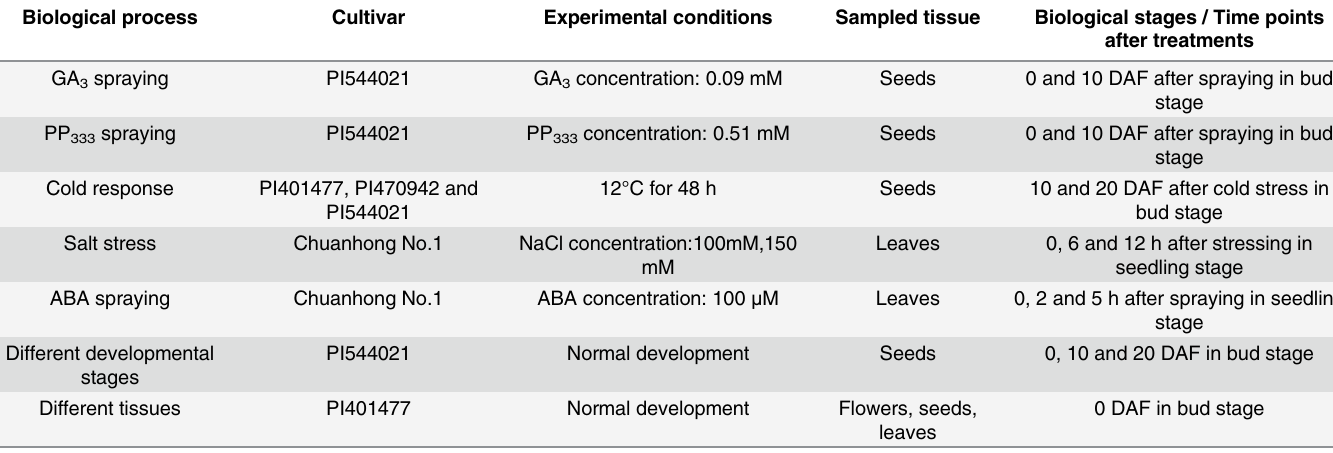
Table 1. Summary of stress assays used to select candidate genes for normalization in